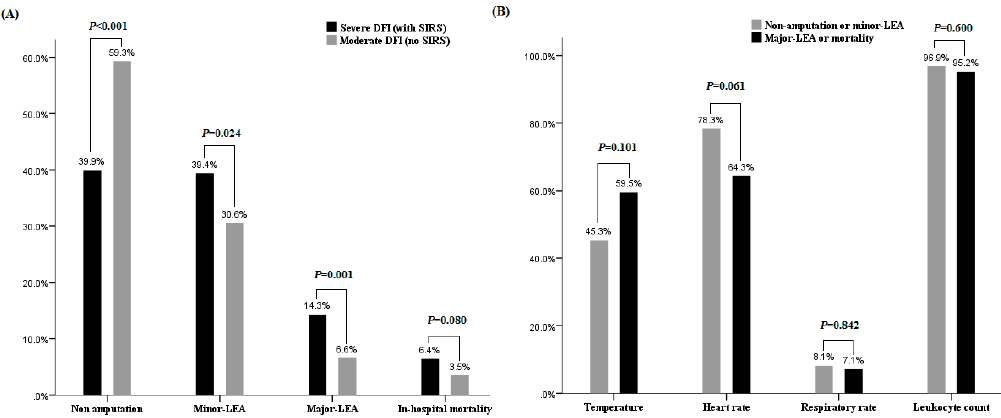
prognosis, respectively, in patients with SIRS (Table 2). The association with MACE history (52.4% versus 24.2%, respectively), retinopathy (73.8% versus 52.2%, respectively), poor peripheral